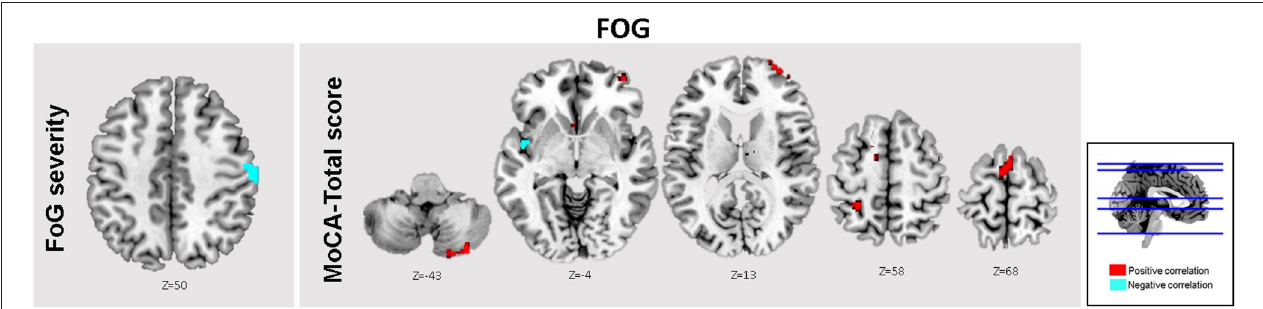
R cerebellum (Crus II)